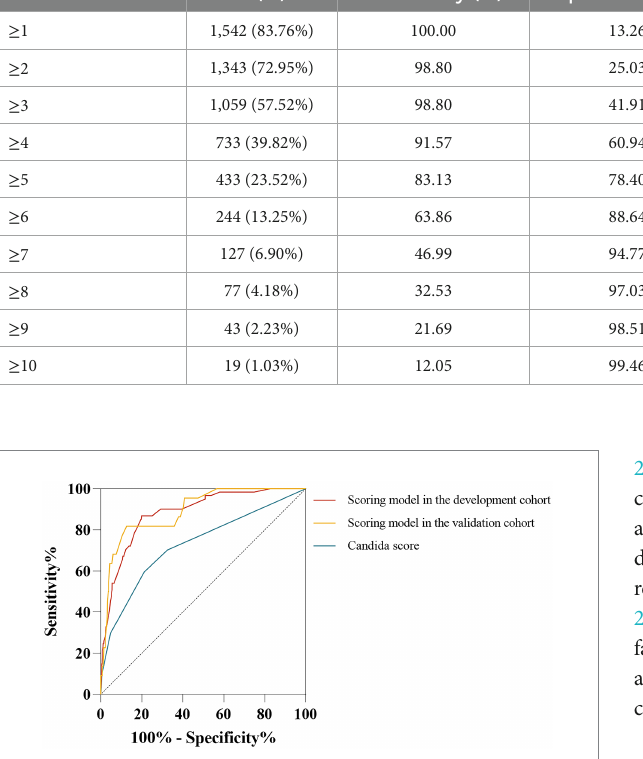
TABLE 4 Performance value of the scoring model at different score thresholds. Predictive score